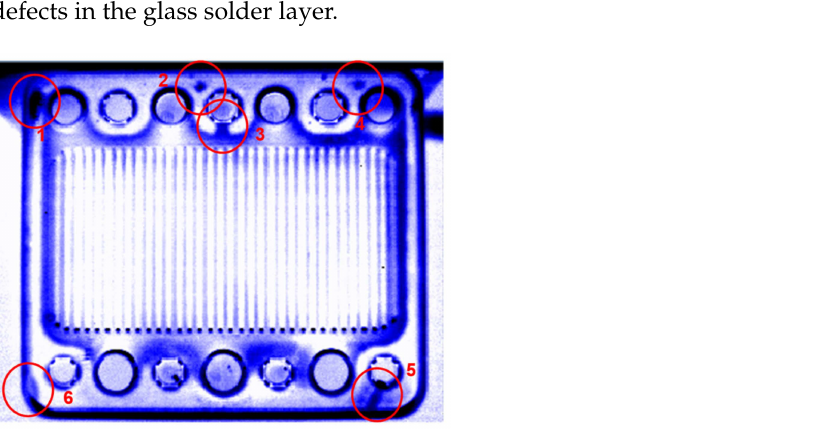
Figure 9. Thermographic phase image of a cell element obtained by flash excited thermography with internal defects as described in Figure 4.